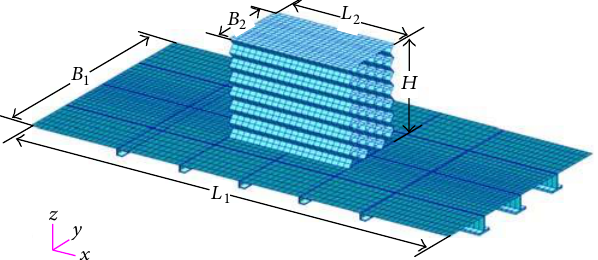
Figure 3: Disposition of the auxetic cellular vibration isolation system, where 𝐵 1 = 710 mm, 𝐿 1 = 1400 mm, 𝐿 2 = 400 mm, and 𝐻 = 300 mm ( 𝐵 2 is affected by the vertical length of the reentrant